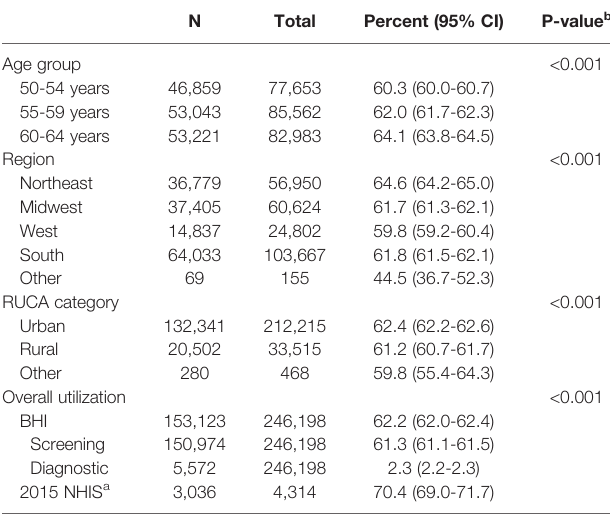
TABLE 1 | Screening and diagnostic mammogram utilization by age, region, and RUCA category.